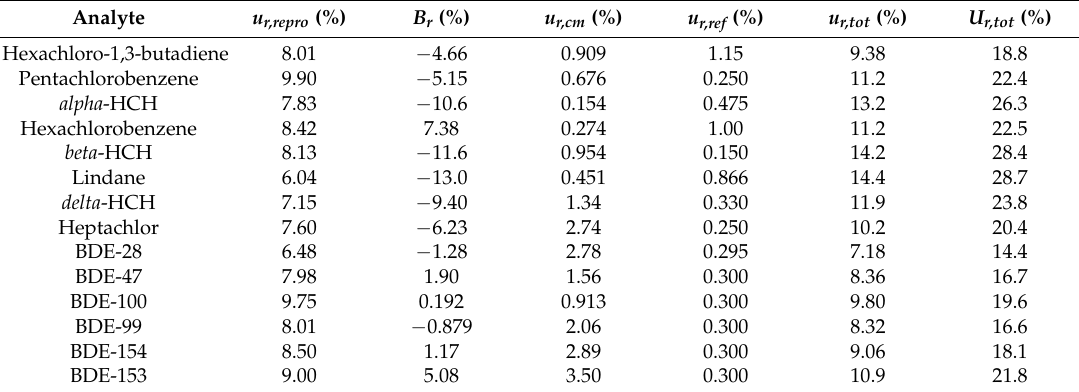
Table 6. Summary of uncertainties obtained for the test analytes using the top-down approach. Analyte u r,repro (%) B r (%) u r,cm (%) u r,ref (%) u r,tot (%) U r,tot (%)